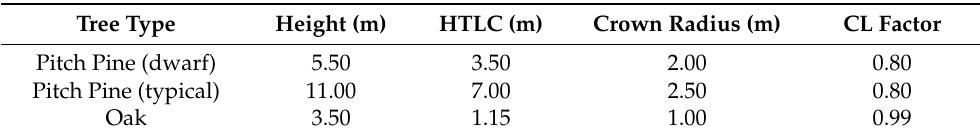
Figure 2. Canopy height and distribution of tall trees across the Spring Hill Fire domain. Table 1. Attributes for dwarf pitch pine, typical pitch pine, and oak used in the Spring Hill Fire